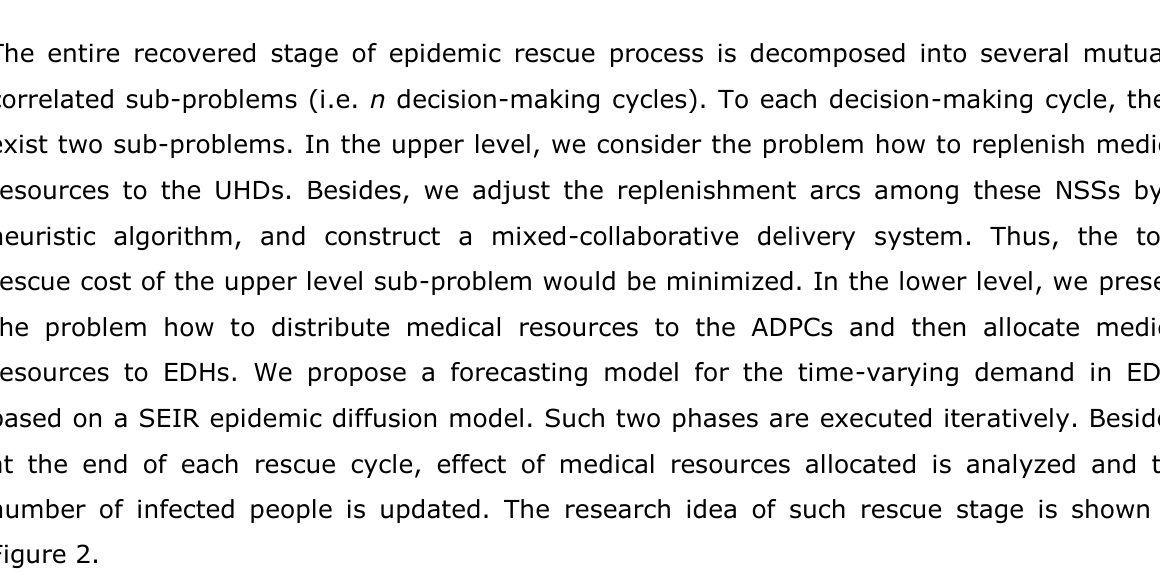
Figure 1. Time-space network of medical resources